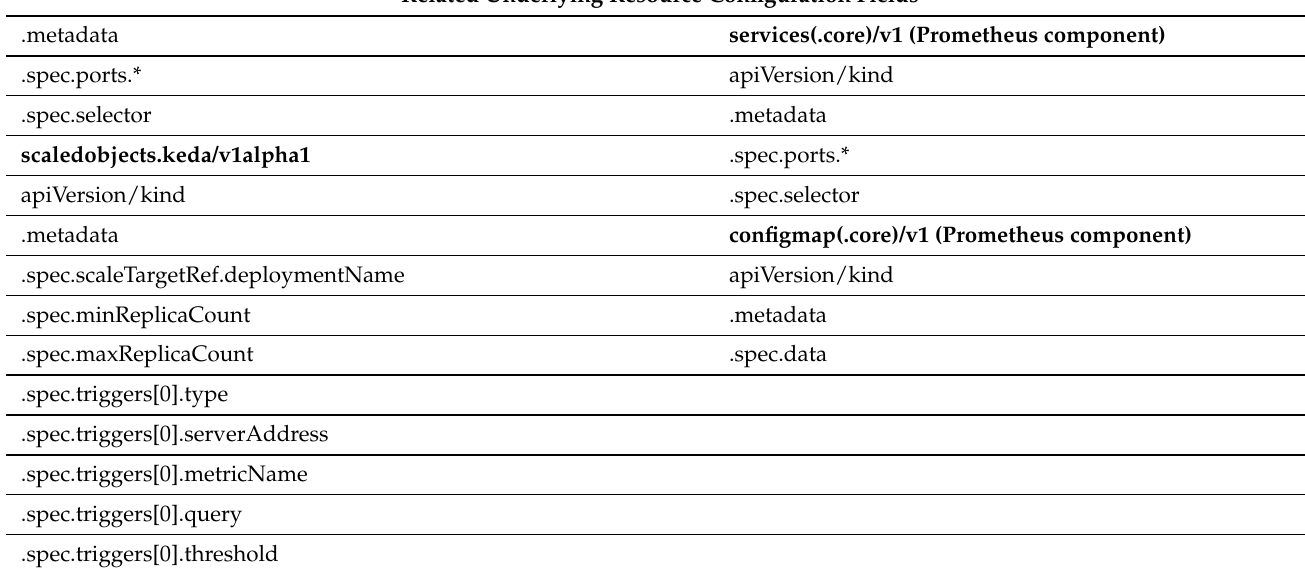
Table 2. Cont. Related Underlying Resource Configuration